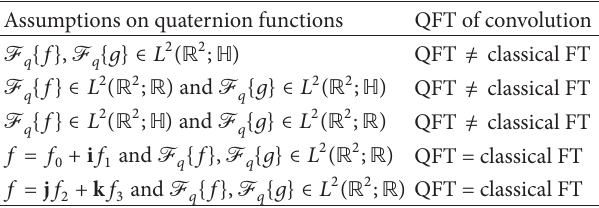
Table 2: Comparison of convolution theorems of the QFT and classical FT for 𝑓, 𝑔 ∈ 𝐿 2 ( R 2 ; H )